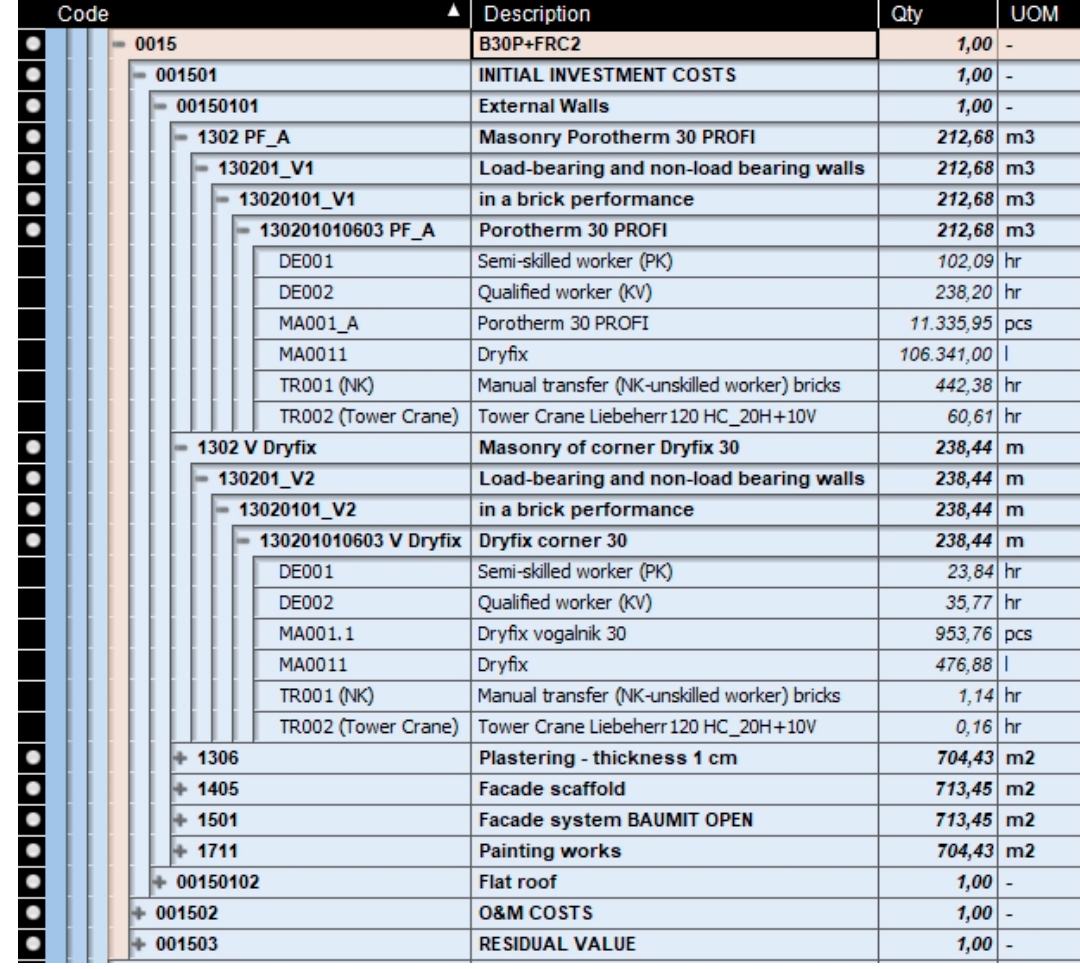
Figure 5. Structure for elements of LCC of variant B30P + FRC2 at U 1 in VO program.